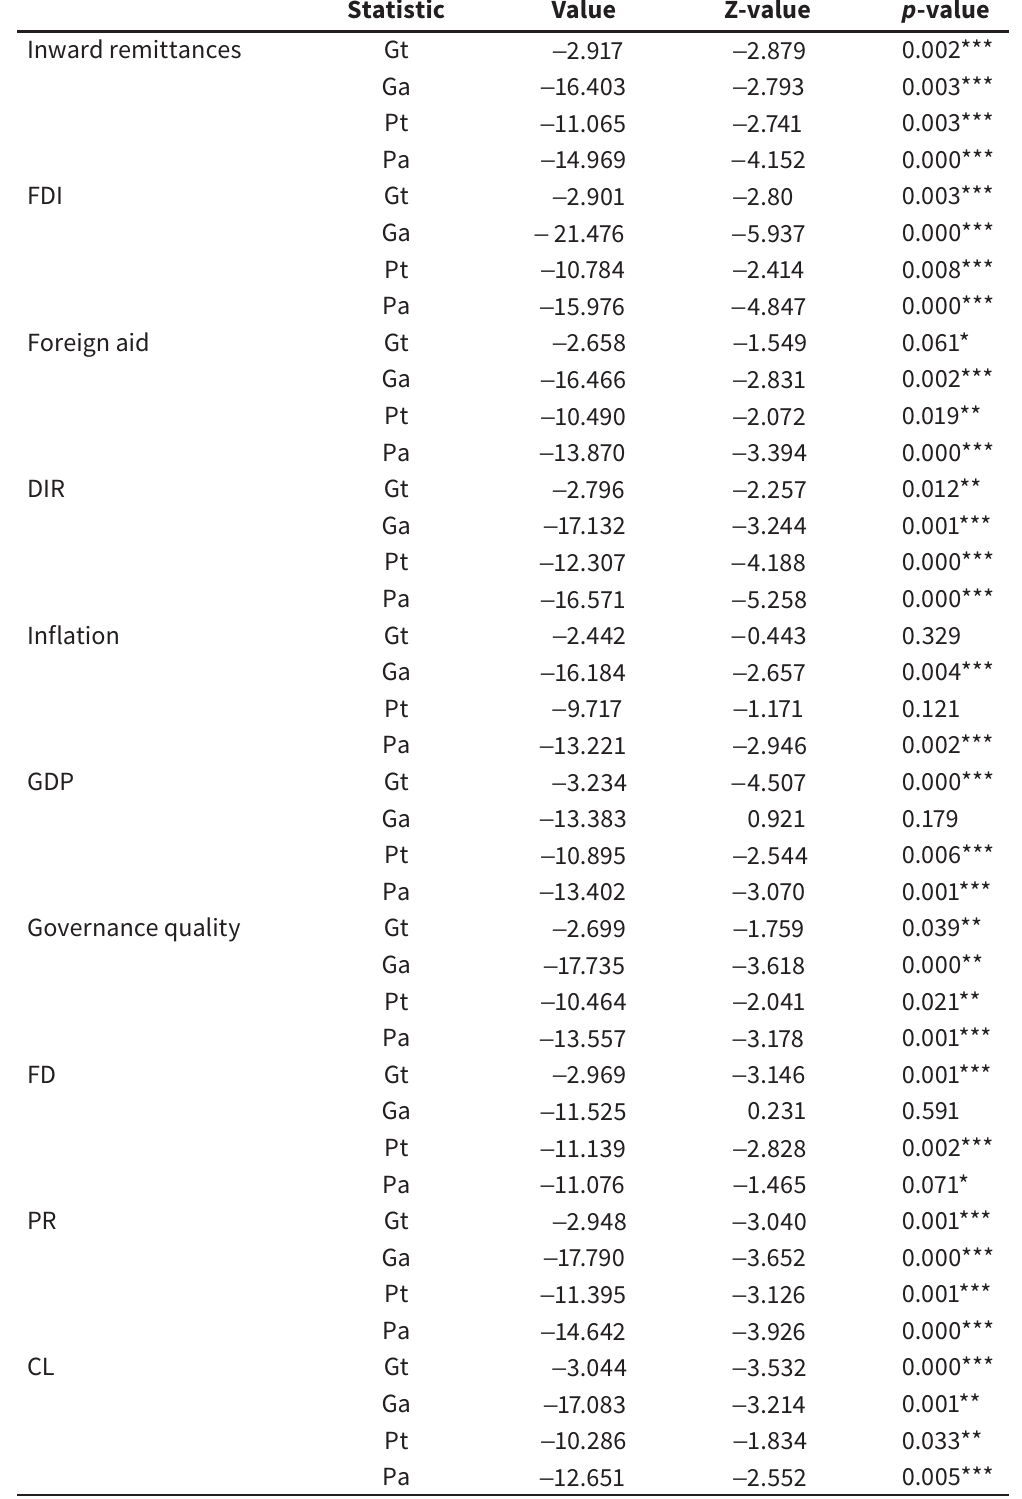
Westerlund (2008) cointegration test Statistic Inward